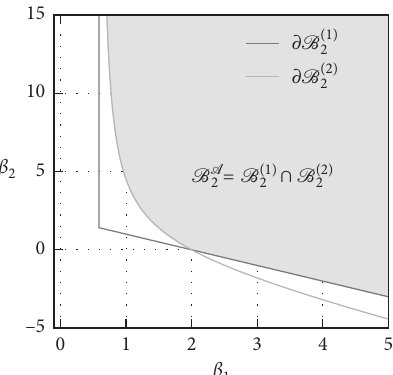
Figure 6: The straight lines depict the border of the set B ( 1 ) curved line represents the border of the set B ( 2 ) region illustrates the set B A